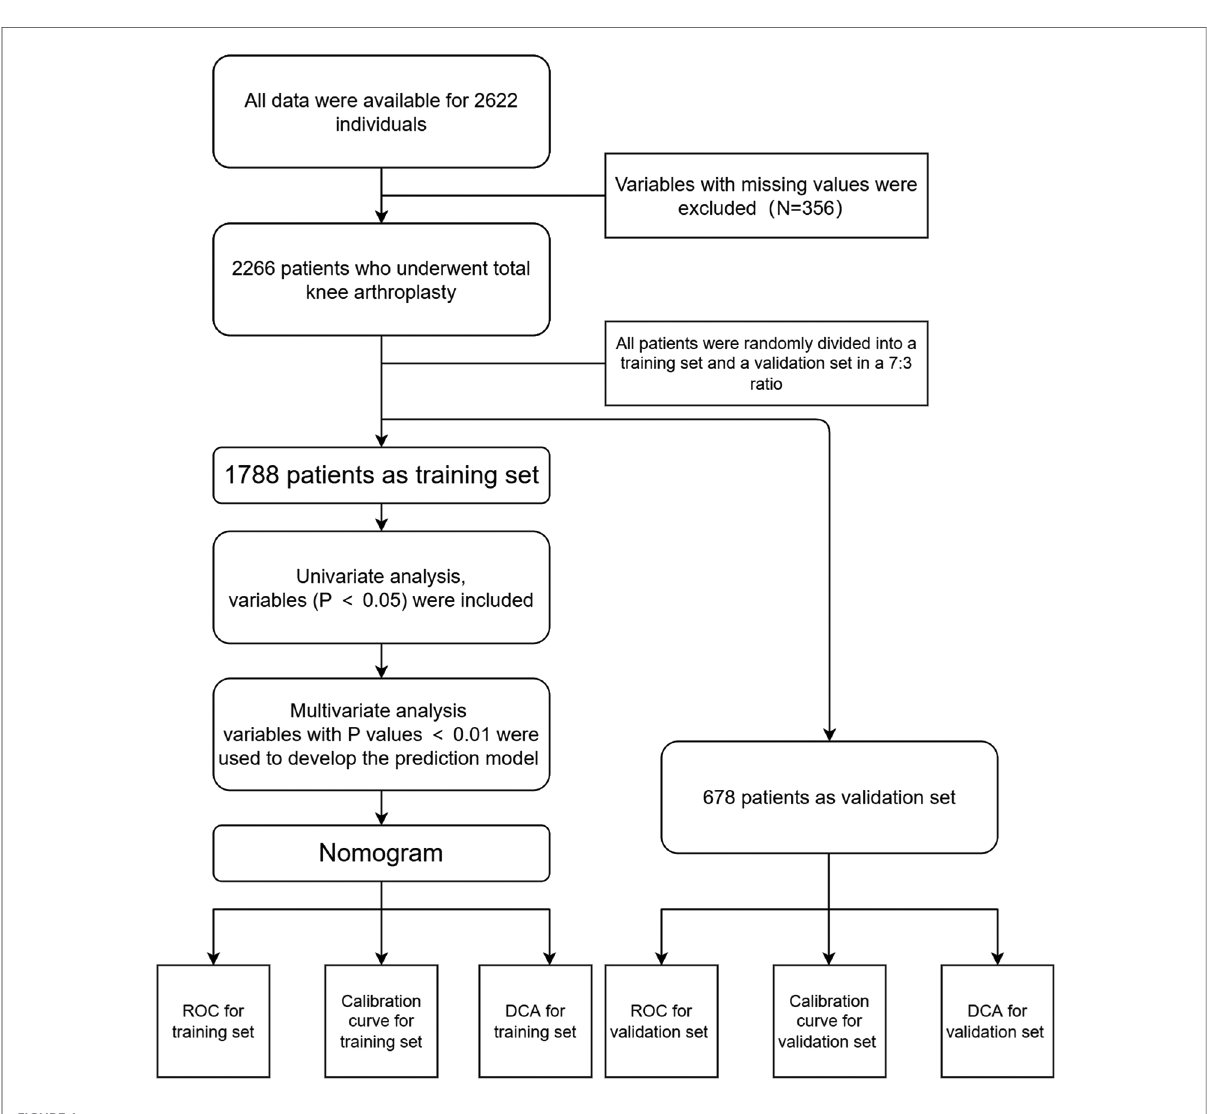
FIGURE 1 Flowchart of our